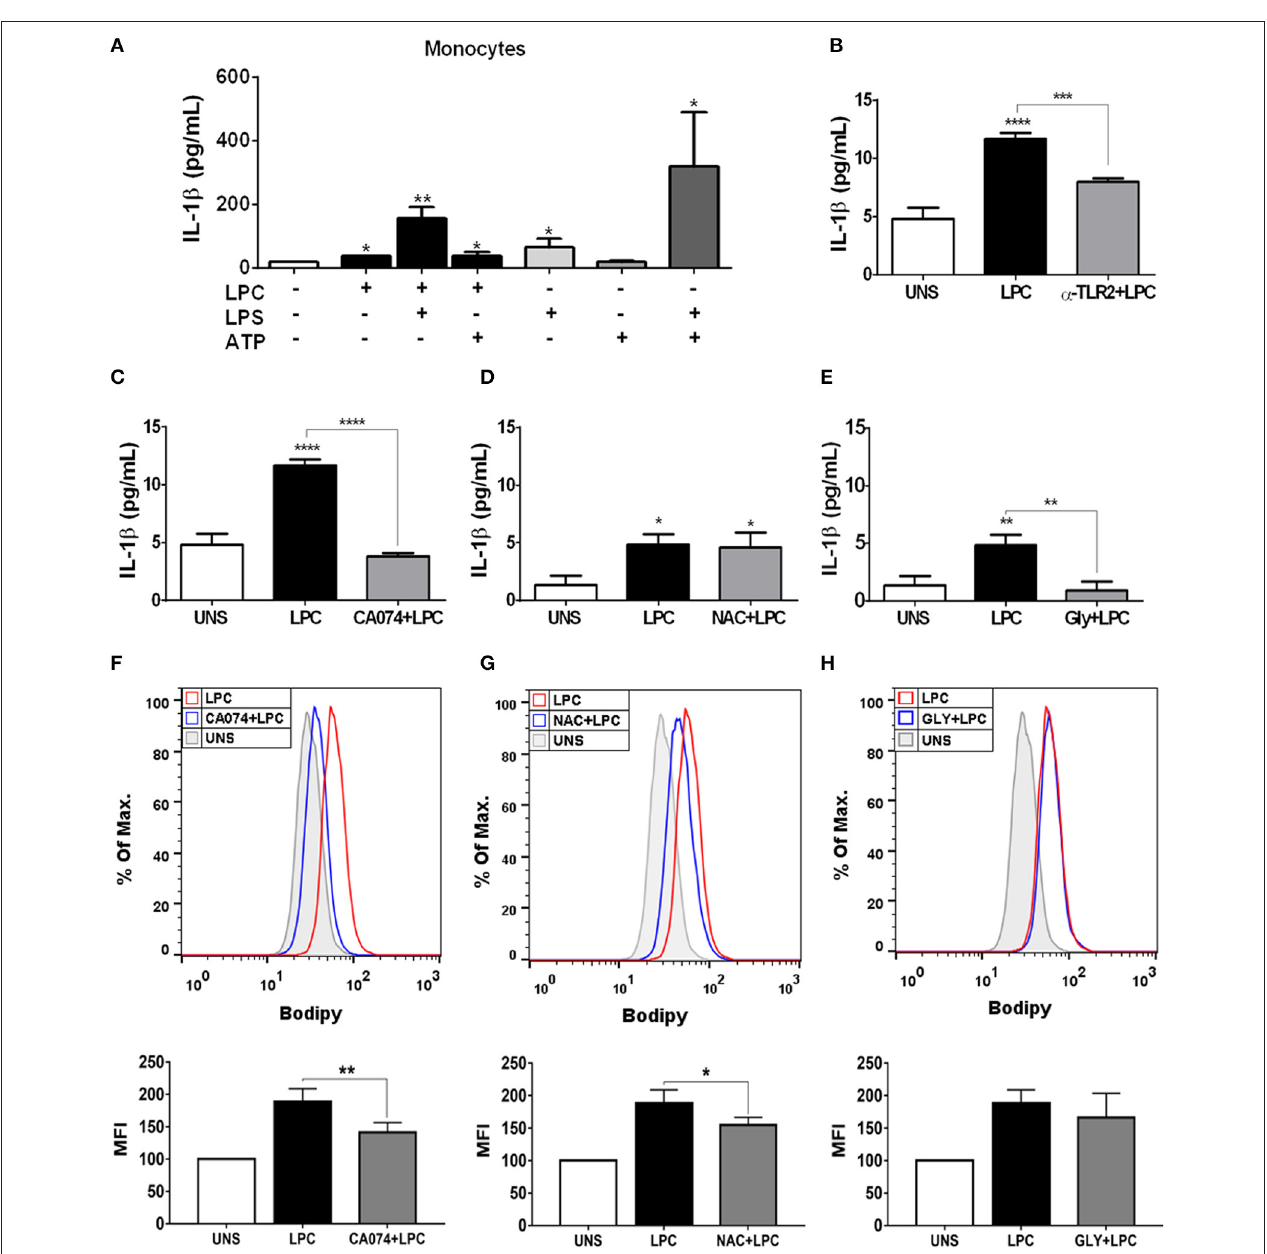
FIGURE 4 | Lysophosphatidylcholine (LPC) induces IL-1 β release and foam cell formation mediated by an inflammasome-dependent pathway in human monocytes. Human monocytes (A) were pretreated with LPS (500ng/ml) 4h before treatment with 1 µ g of LPC for 24h. After this treatment, the cells were treated with ATP (1mM). One hour later, the supernatants were collected, and the levels of IL-1 β were measured by ELISAs. Data are expressed as the average of triplicate wells. In addition, human monocytes were pretreated with different inhibitors: (B) TLR2 neutralizing antibody ( α -TLR2), (C) cathepsin B inhibitor (CA-074), (D) reactive oxygen species (ROS) inhibitor [ N -acetyl- L -cysteine (NAC)], and (E) inhibitor of potassium efflux [glibenclamide (GLY)] for 1h and stimulated with 1 µ g/ml of LPC for 24h; the supernatants were collected, and the levels of IL-1 β were measured by ELISAs. The bar graph represents one experiment performed twice in triplicate. Human monocytes were pretreated with different inhibitors (F) cathepsin B inhibitor (CA-074), (G) reactive oxygen species (ROS) inhibitor [ N -acetyl- L -cysteine (NAC)], and (H) inhibitor of potassium efflux [glibenclamide (GLY)] for 1h and stimulated with 1 µ g/ml of LPC for 24h, the lipid droplets were stained in cells with BODIPY and analyzed by flow cytometry. Histograms are representative of three independent experiments. Each bar graphic represents the mean fluorescence intensity (MFI), and bars show significant differences and represent the 95% confidence interval (* p < 0.05, ** p < 0.01, *** p < 0.005, and **** p < 0.0001) of the cells stimulated with LPC or UNS (unstimulated